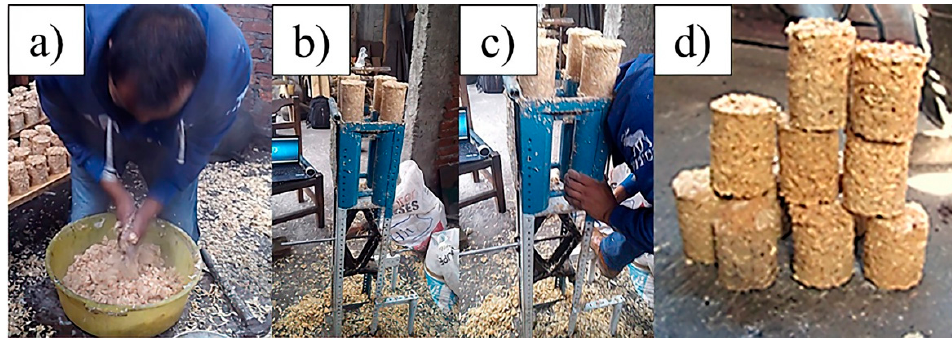
Figure 2. ( a ) Preparation of the mixture, ( b ) Compaction of the mixture, ( c ) Obtaining the briquettes, ( d ) Prepared briquettes for tests.